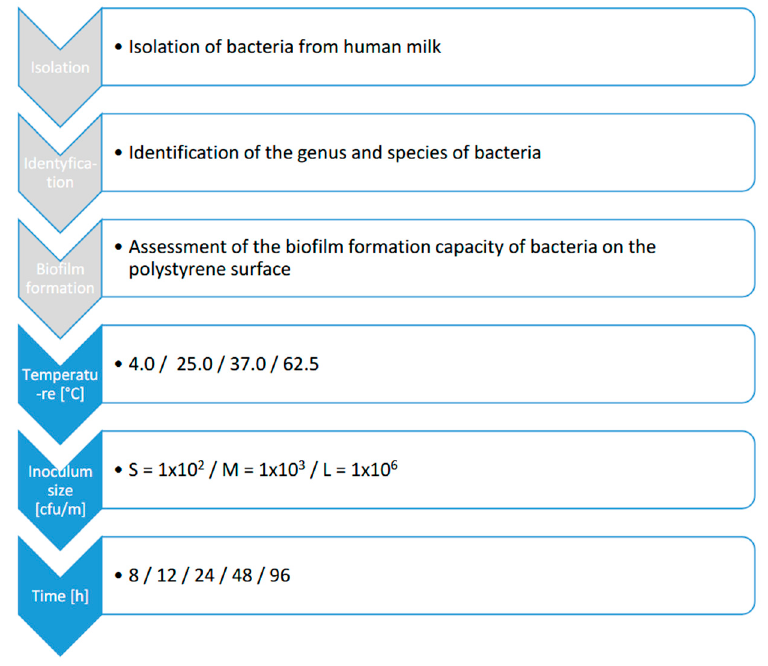
Figure 1. Research scheme .